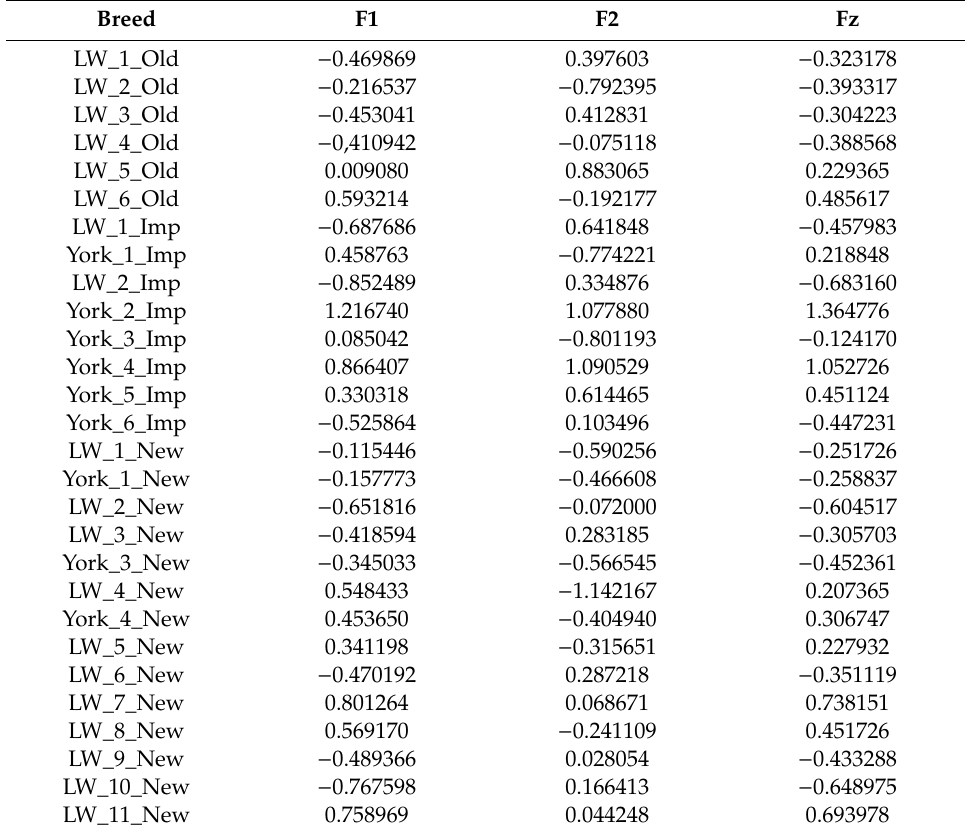
Table 4. Scores and general PCA scores of di ff erent